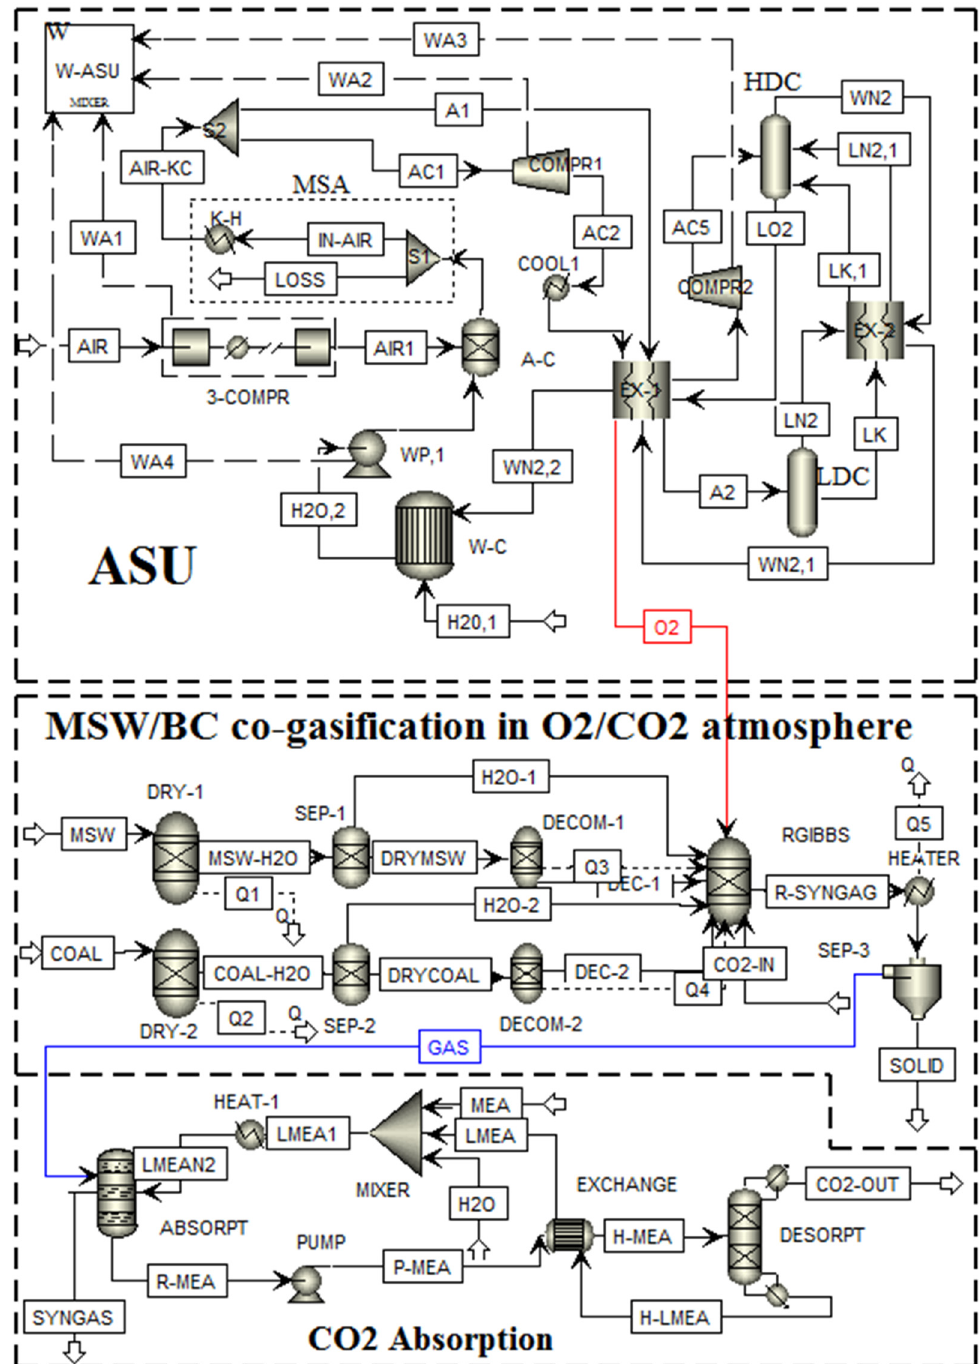
/ BC CO / O 2 2 co-gasification system with Aspen